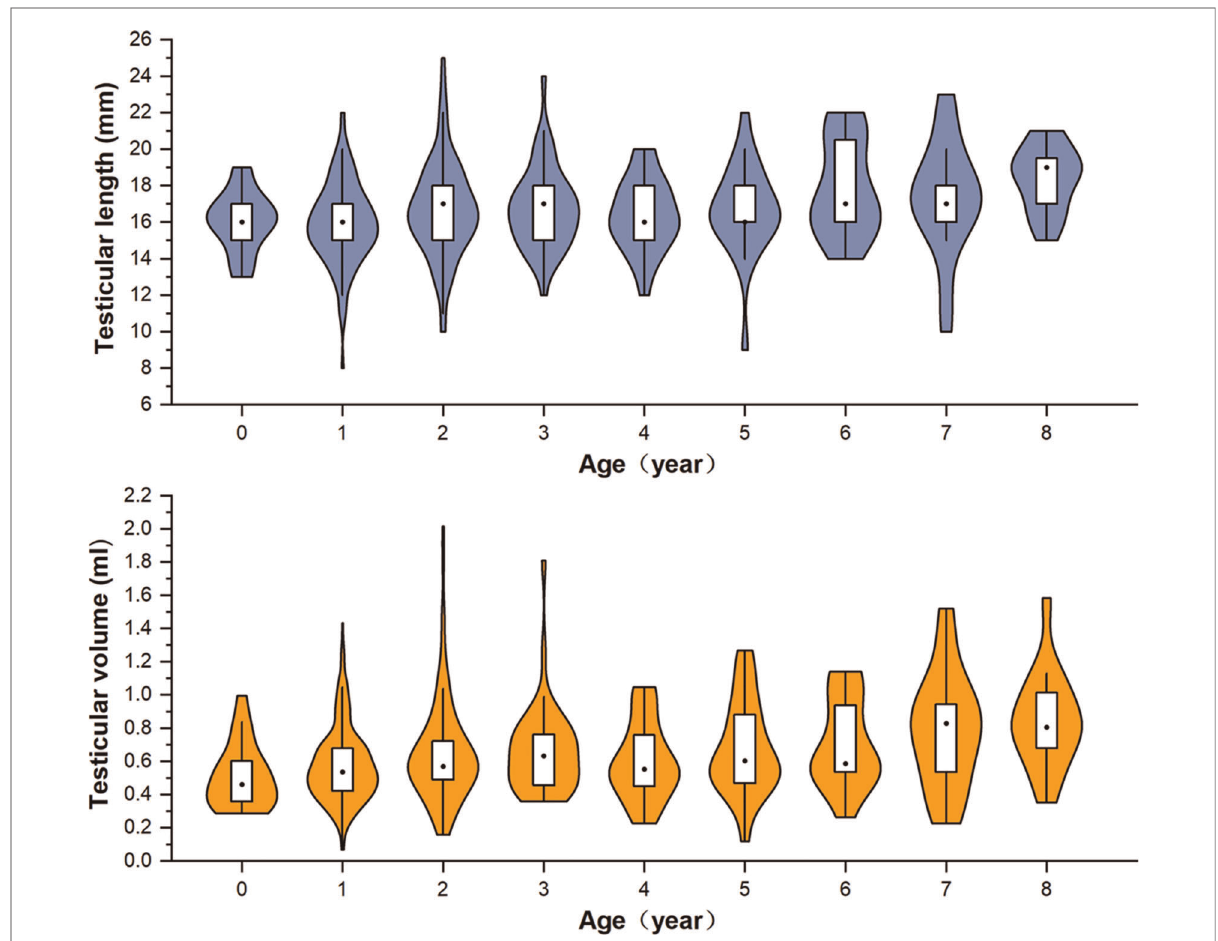
FIGURE 3 Violin-box plot showing the distribution and density of testicular length and volume in boys aged 0 – 8 years with